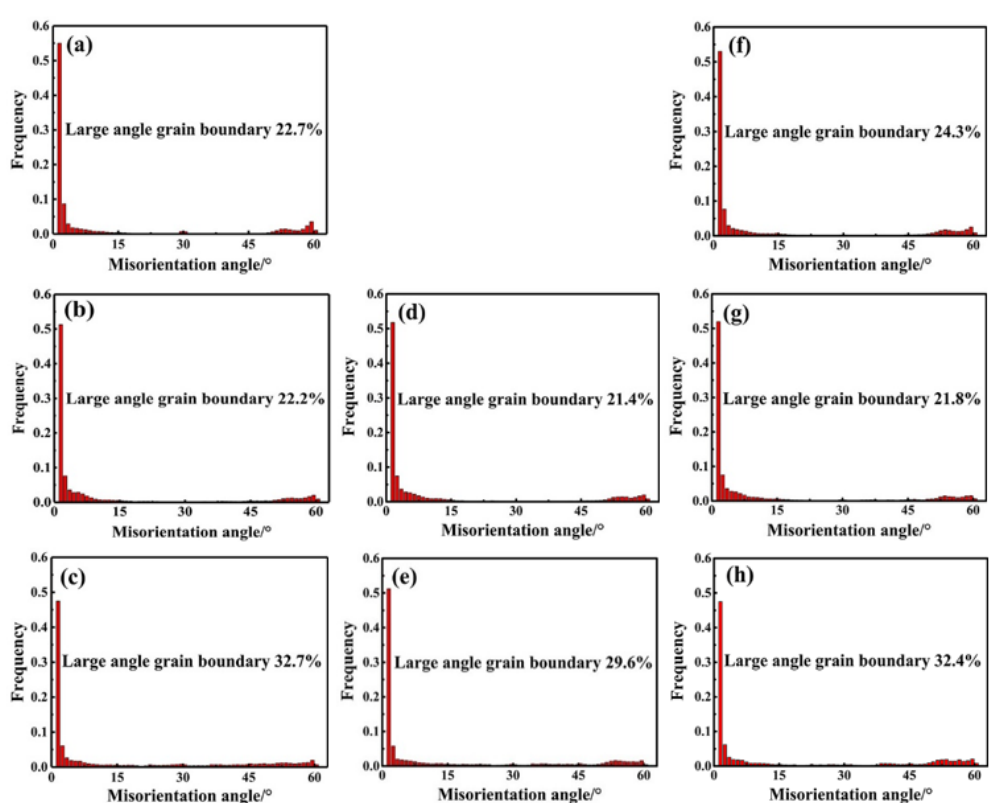
Figure 7. Grain-boundary misorientation angle distribution at the different temperature measurement points. Images ( a – h ) show the results for points P1–P8, respectively.